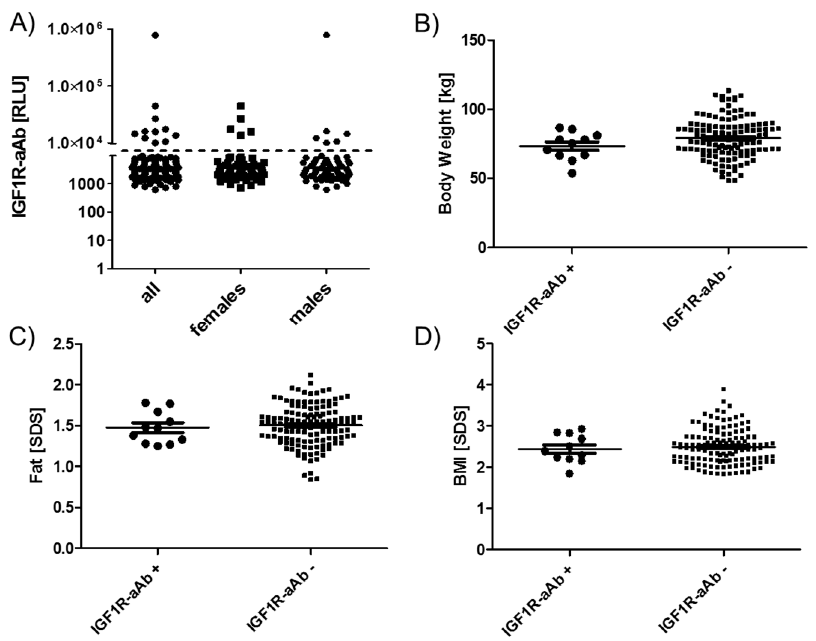
Figure 4. Anthropometric parameters of IGF1R-Ab-positive and -negative subjects. Subjects were categorized as IGF1R-aAb-positive or -negative, as explained in Figure 1. The two resulting groups of subjects, with or without IGF1R-aAb, were not different with respect to ( A ) sex distribution, ( B ) body weight, ( C ) body fat, or ( D ) BMI. Analysis by two-sided non-parametric U Mann–Whitney Test.